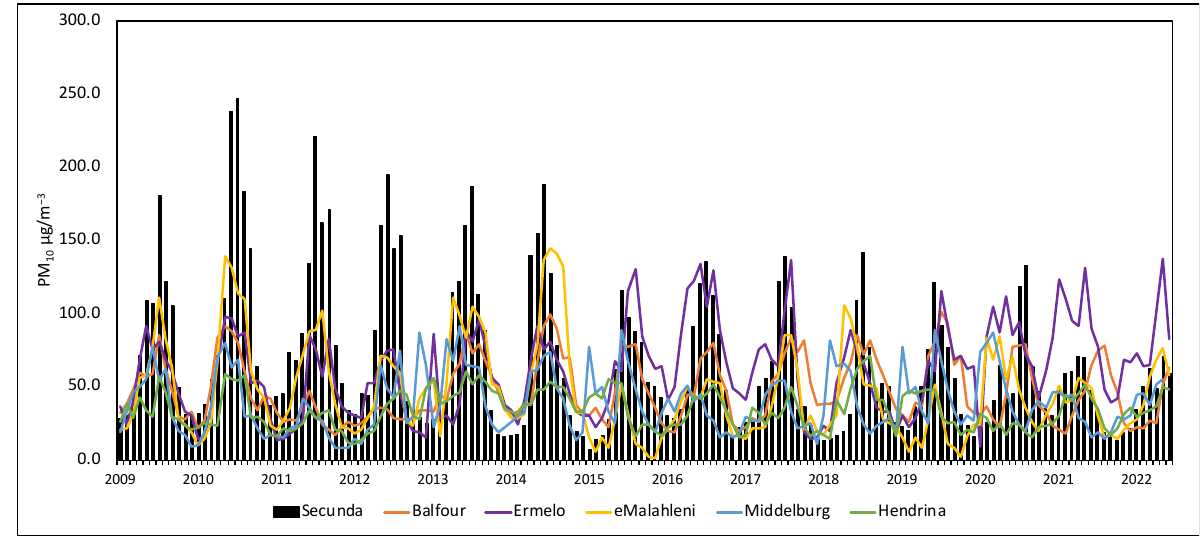
Figure 4. Overall monthly concentration between Secunda and other cities located within a range of 100km in the Mpumalanga province.